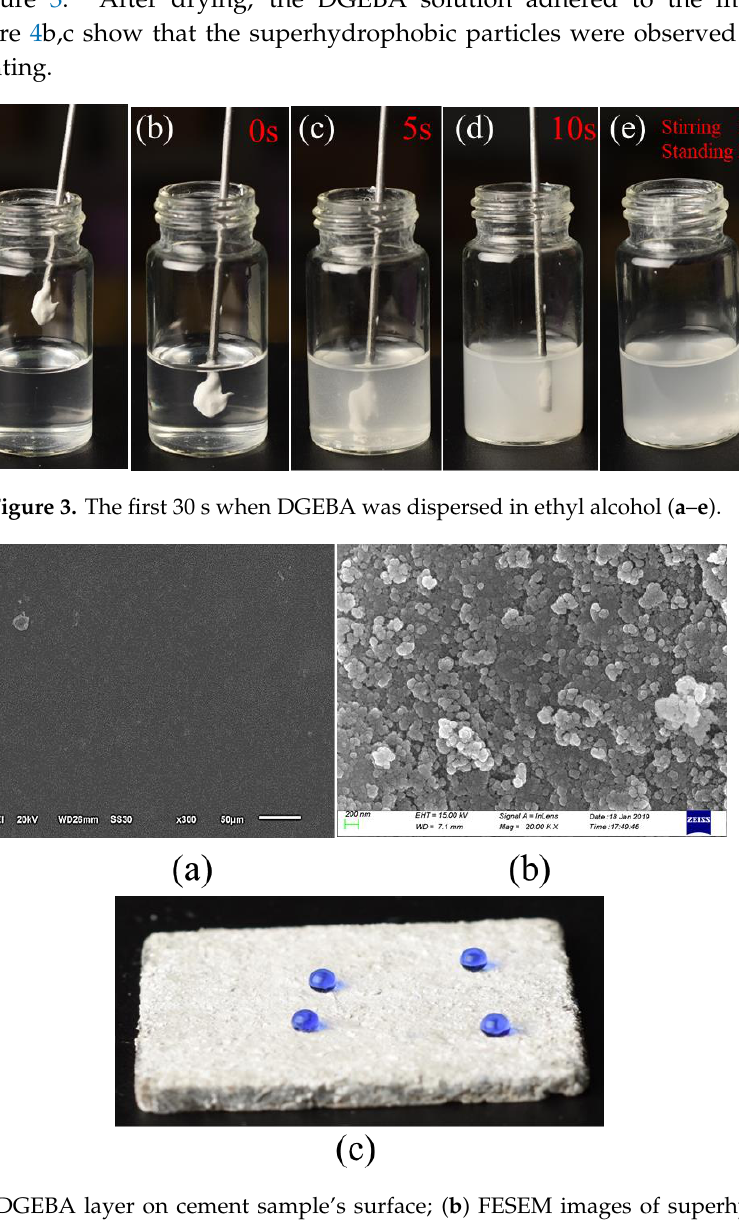
Figure 4. ( a ) DGEBA layer on cement sample’s surface; ( b ) FESEM images of superhydrophobic particles on DGEBA; ( c ) SiO 2 aerosol @ DGEBA coating.